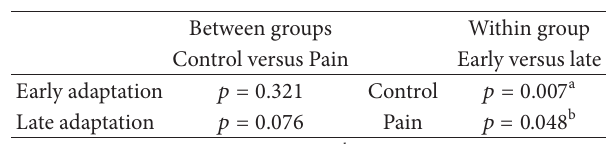
Table 1: Post hoc analyses for the time × group interaction on the relative timing of error variable. Uncorrected 𝑝 values are presented. According to the Benjamini-Hochberg procedure, the critical 𝑝 value = 𝛼/𝑚 ∗ 𝑖 , where m corresponds to the number of hypotheses tested ( 𝑚 = 4 ) and 𝑖 corresponds to the rank of the tested hypothesis based on the uncorrected 𝑝